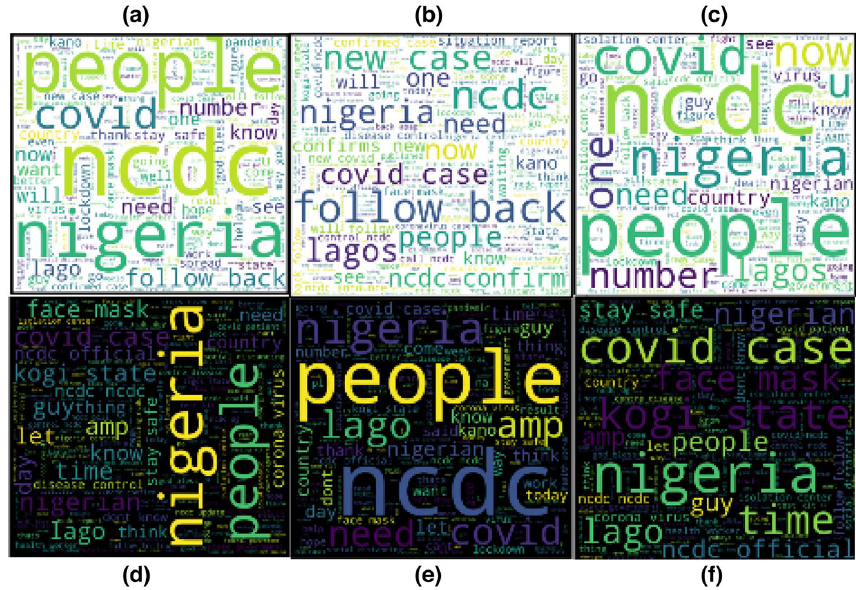
Fig. 10 Diagram showing the word cloud of a positive tweets using VADER, b negative tweets using VADER, c neutral tweets using VADER, d positive tweets using TextBlob, e negative tweets using TextBlob and f neutral tweets using